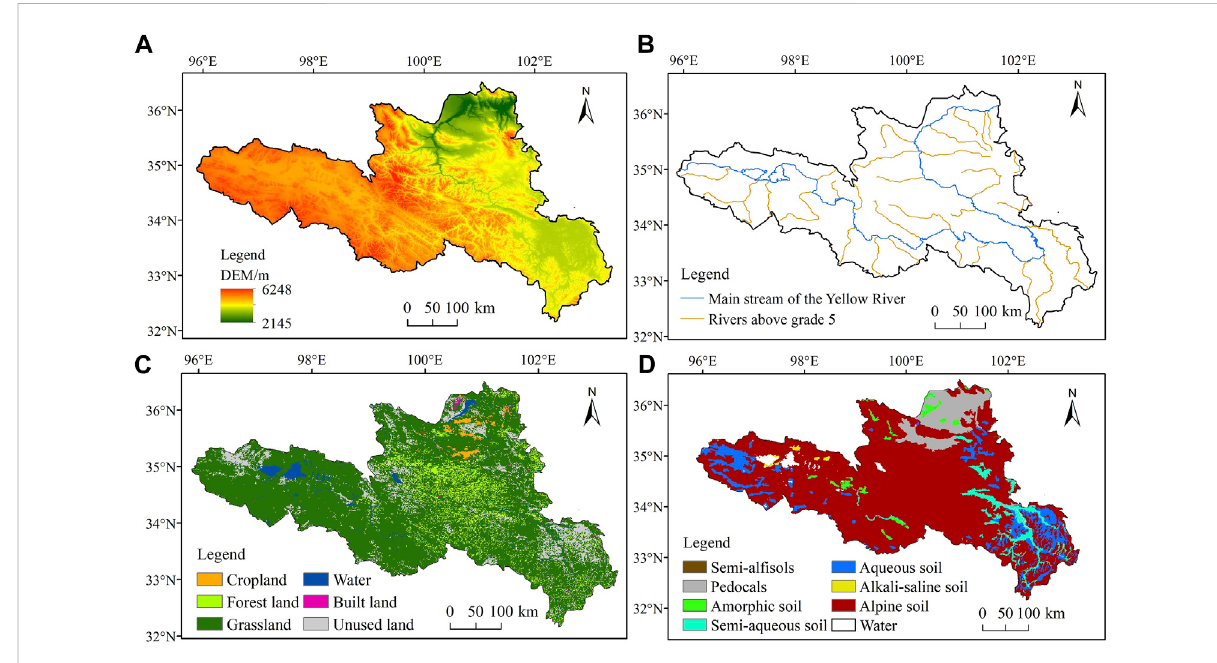
FIGURE 2 Regional distribution of the main input parameters of the SWAT model: (A) DEM; (B) water system; (C) land use type (level 1); and (D) soil type (order